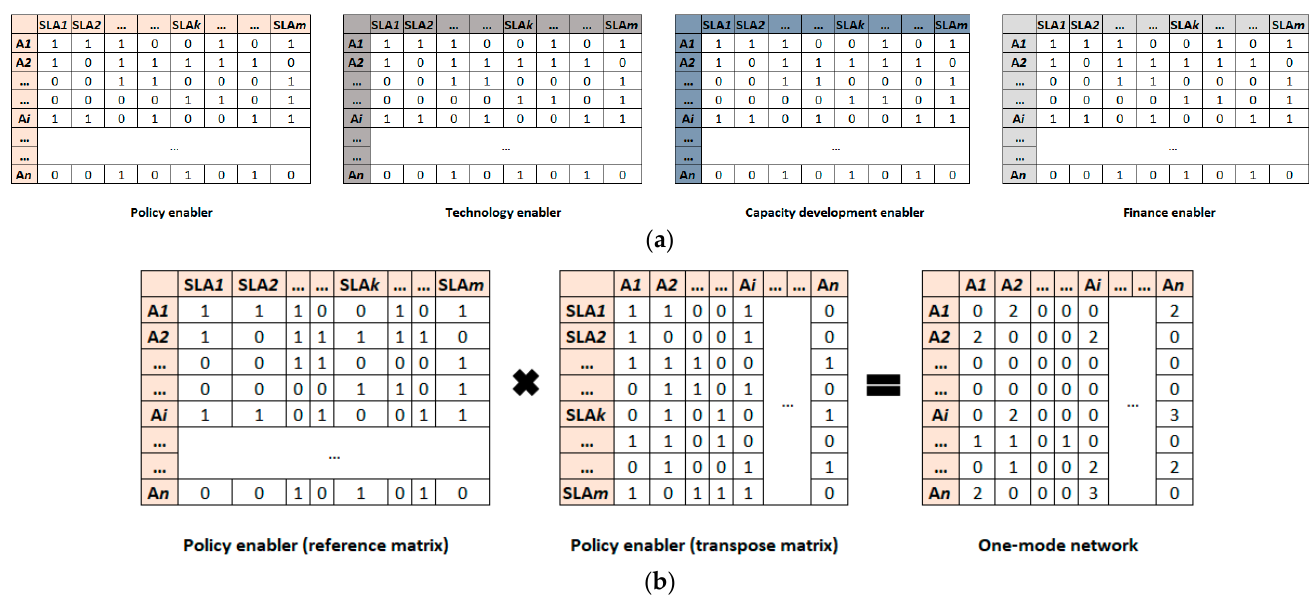
Figure 2. Reference matrices ( a ) . Multiplication of the reference matrix by its transpose matrix ( b ).